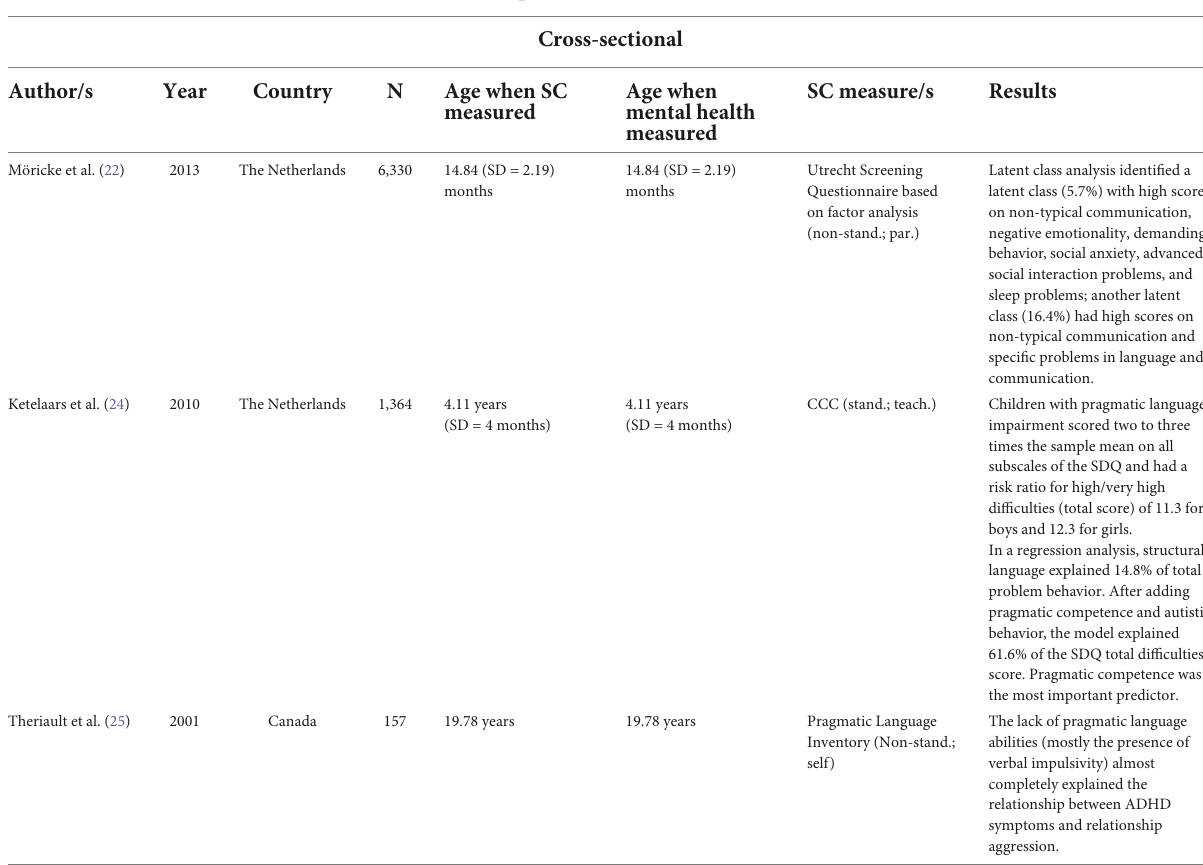
TABLE 1 Characteristics of population-based cross-sectional